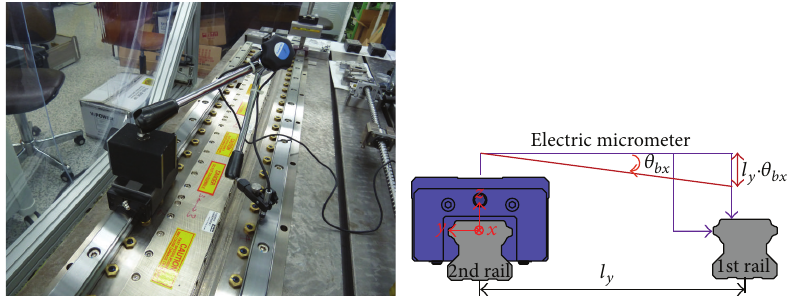
Figure 13: Measurement of the parallelism error between the two